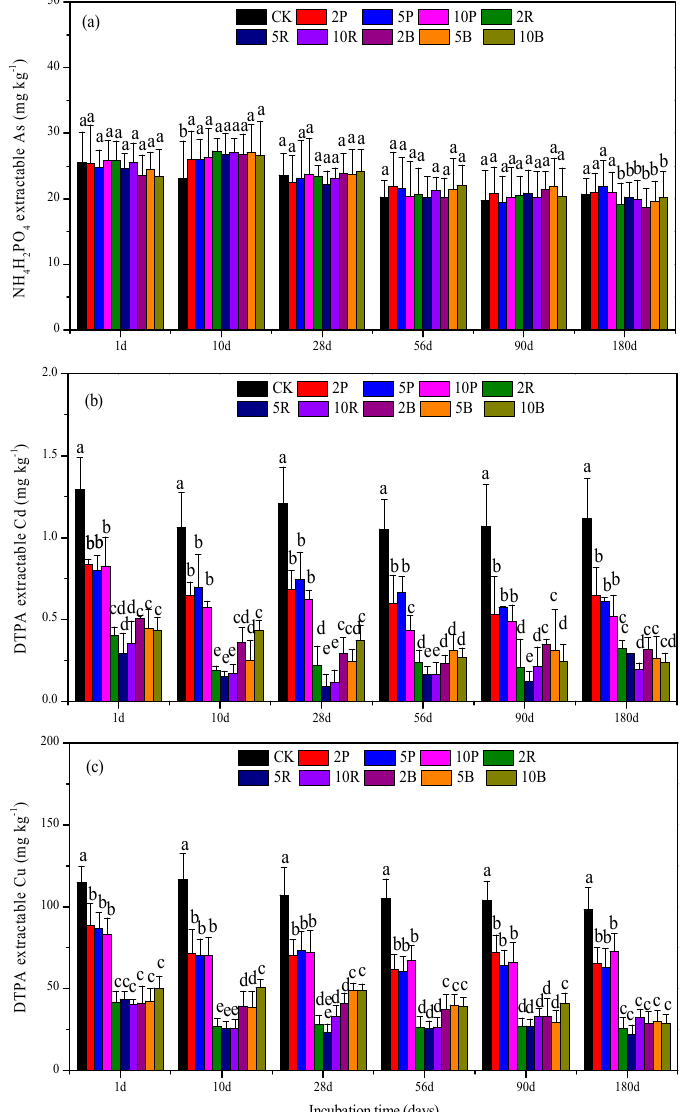
Figure 3. Changes in the concentrations of NH 4 H 2 PO 4 − extractable As ( a ), DTPA − extractable Cd ( b ), and DTPA − extractable Cu ( c ) over 180 days with phosphate, red mud, and biochar (CK: control; 2P: 2% phosphate; 5P: 5% phosphate; 10P: 10% phosphate; 2R: 2% red mud; 5R: 5% red mud; 10R: 10% red mud; 2B: 2% biochar; 5B: 5% biochar; 10B: 10% biochar). Error bars represent ± standard error. Lowercase letters above the error bars indicate significant differences among different treatments at p < 0.05 level.